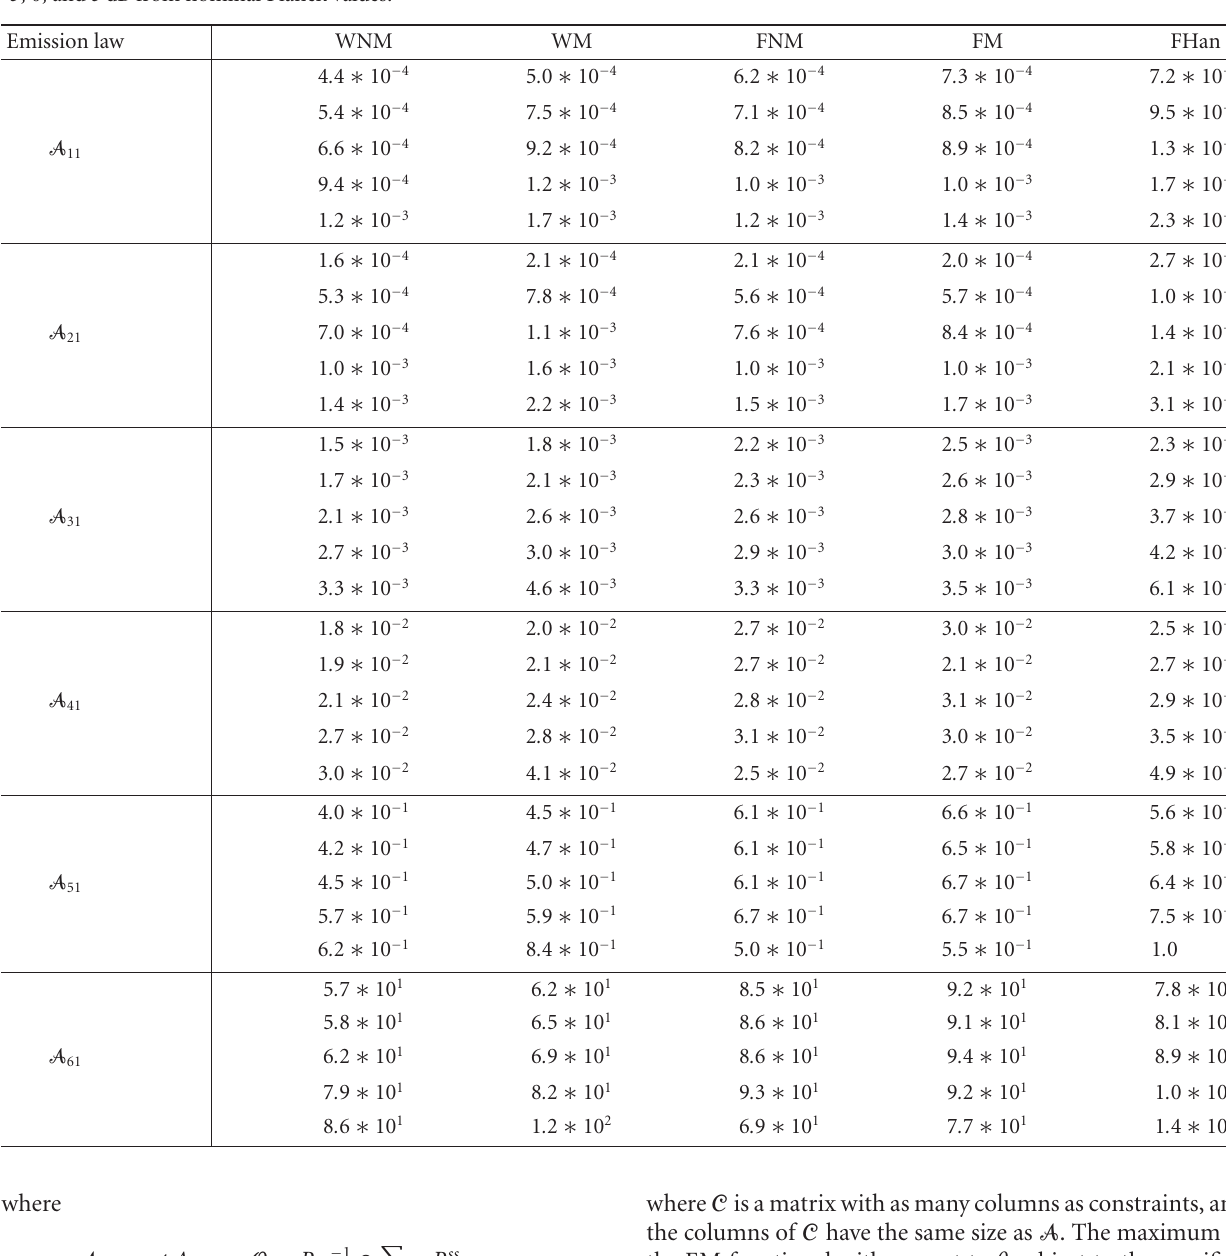
Table 6: Standard deviations of the relative errors on the estimated emission laws A i 1 of CMB in Planck’s HFI six channels. The column labels WNM, WM, FNM, FM, FHan are for the di ff erent configurations, respectively: wSMICA without mask, wSMICA with mask, fSMICA without mask, fSMICA with mask, and fSMICA with Hanning apodizing window. The five figures in each box are for noise variance -20, -6, -3, 0, and 3dB from nominal Planck